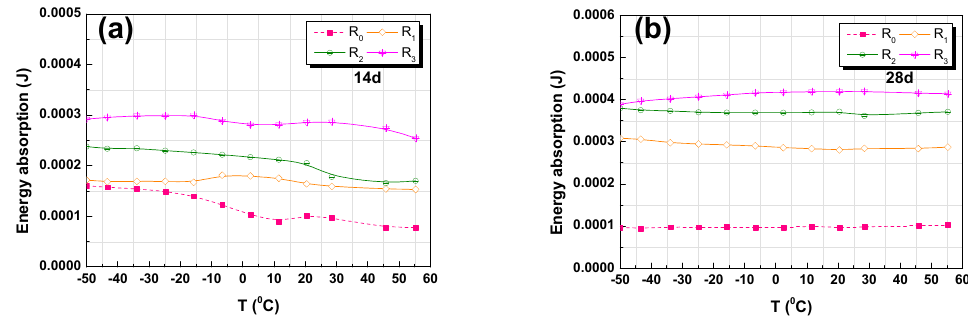
Figure 10. DMA analysis results of energy absorption versus temperature: ( a ) 14-day; ( b ) 28-day.